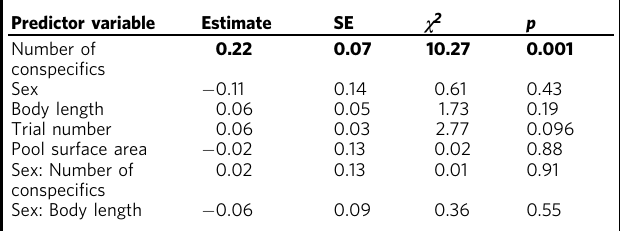
observations = 5070.